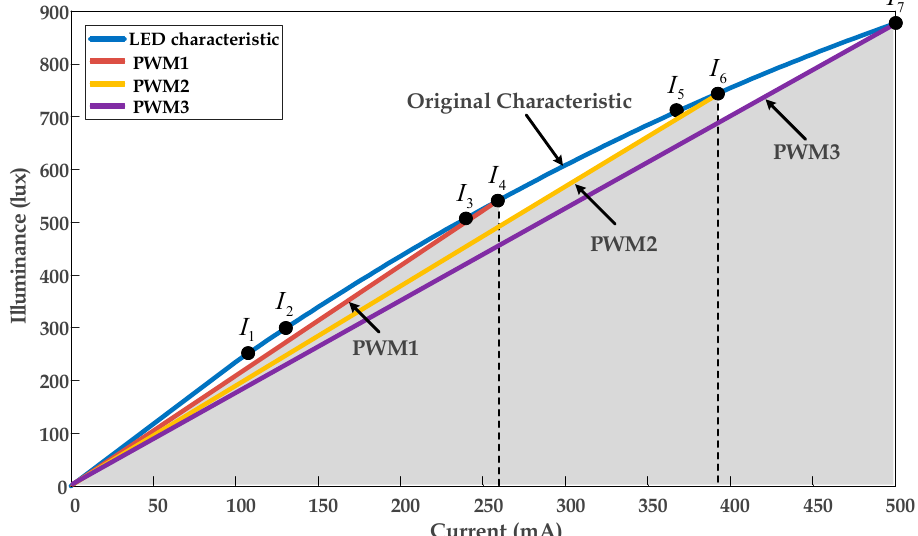
Figure 6. Illumination characteristics of the original and obtained by the other three PWM dimming controls.